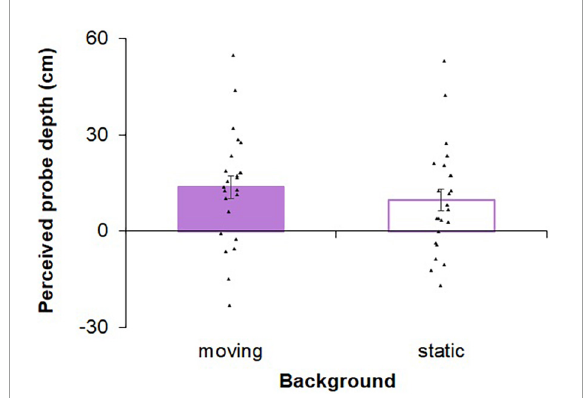
FIGURE4 Results of the perceived depth of the aperture in the additional experiment. Each bar graph represents an average of the differences from the simulated probes’ depth (i.e., 3.0 m ahead of them) across participants in each background condition. Dots indicate individual critical margins in each of the self-motion conditions. Larger positive and negative values indicate farther and nearer probes perception from the simulated probes’ depth, respectively. Error bars show standard